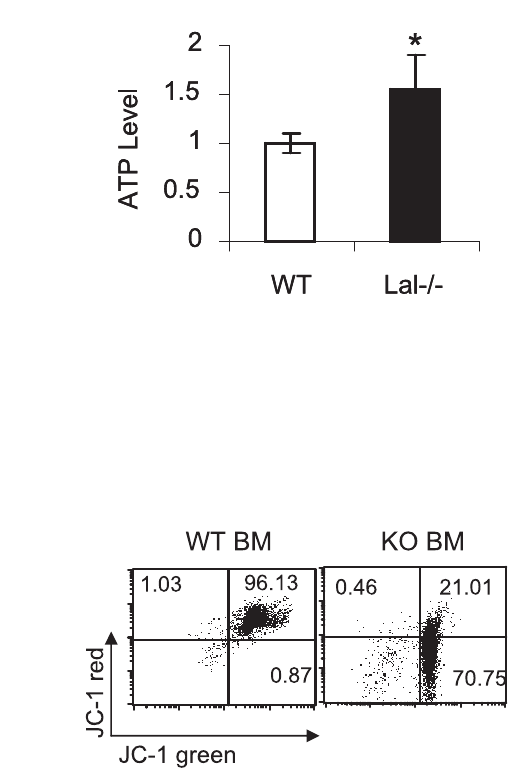
Figure 4. ATP production and mitochondrial potential analyses of lal 2 / 2 bone marrow MDSCs. A ). ATP concentrations in Ly6G + MDSCs from the bone marrow of lal + / + mice and lal 2 / 2 mice. Results are means of 4 independent experiments. n=3, **, p , 0.01, *, p , 0.5; B ). Mitochondrial membrane potential of CD11b + Ly6G + MDSCs from the bone marrow of lal + / + mice and lal 2 / 2 mice was analyzed by JC-1 staining. Positive staining of JC-1 red represents healthy mitochondria. Transition from negative staining of JC-1 red to positive staining of